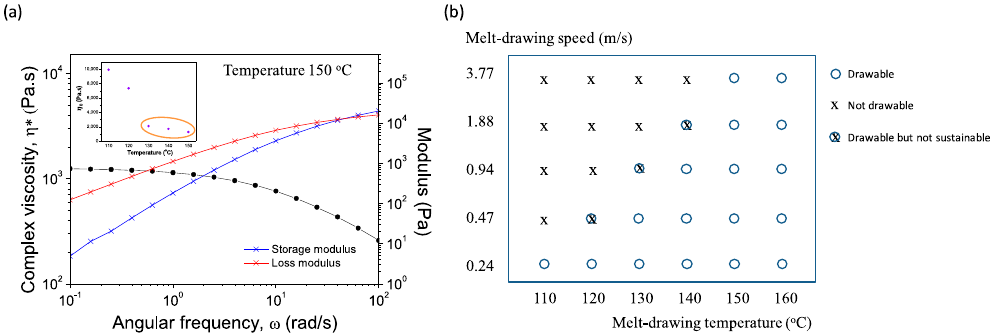
Figure 2. ( a ) Dynamic frequency sweep test at 150 °C. Inset illustrates the zero-shear viscosities at different temperatures; ( b ) Melt-drawing ability analysis of PLC at different melt temperatures and melt-drawing speeds.